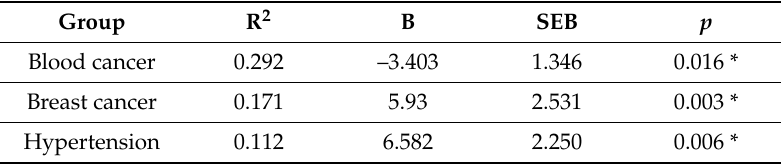
Table 16. Standard regression analysis summary for variables predicting Emotion Dysregulation (ED) in di ff erent